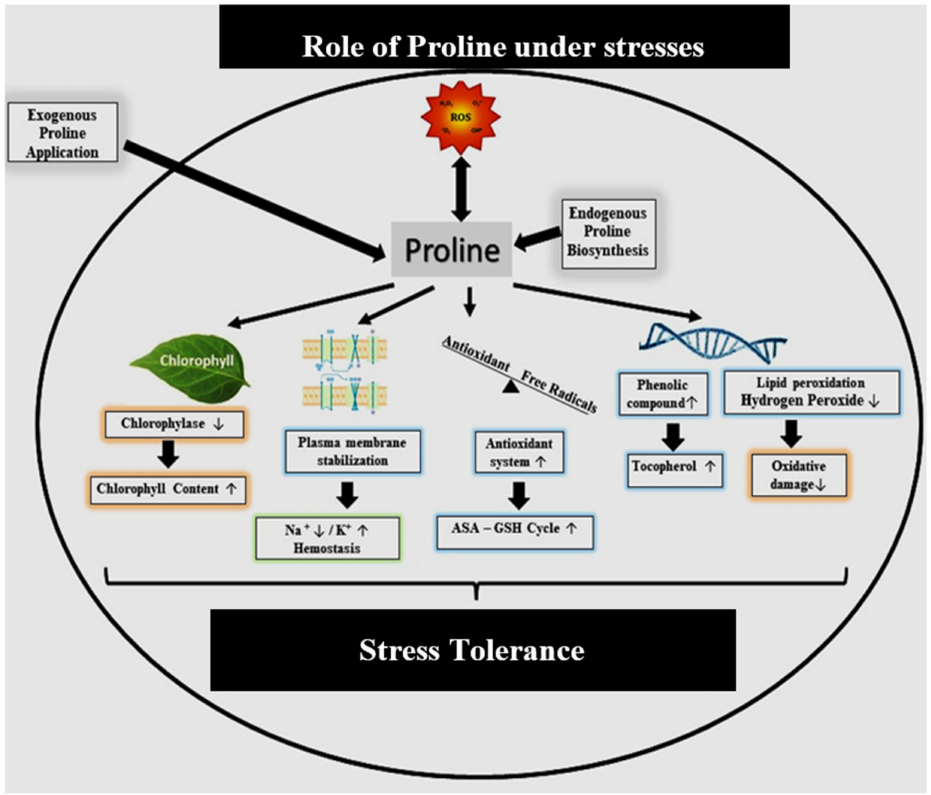
Figure 2. The pivotal role of exogenous and endogenous proline in improvement in plant status under drought and salinity stress